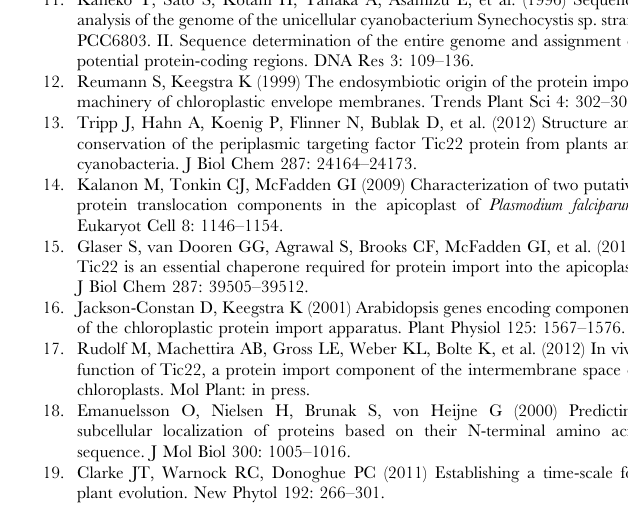
reactions were allowed to proceed for 20 minutes. At the end of